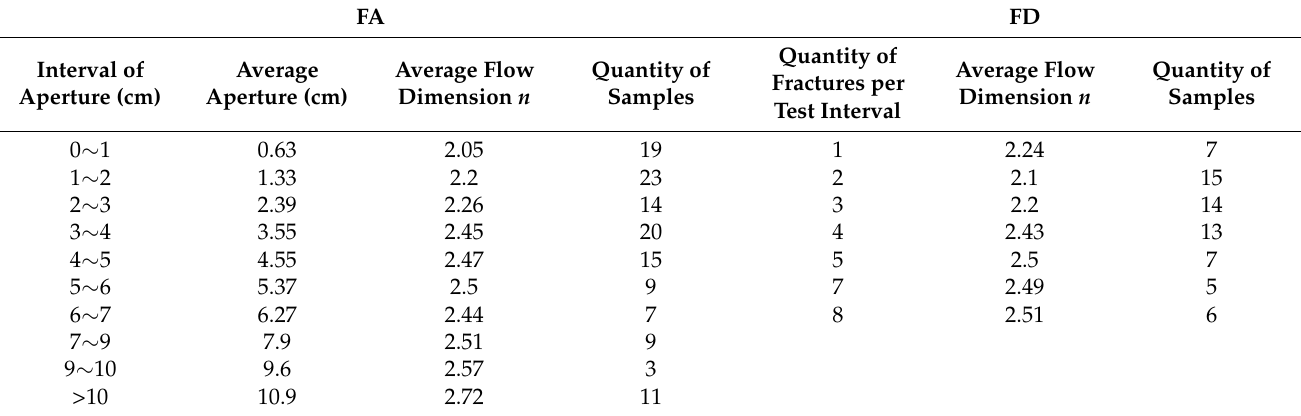
Table 3. Results for grouping fracture aperture (FA) and fracture density (FD)